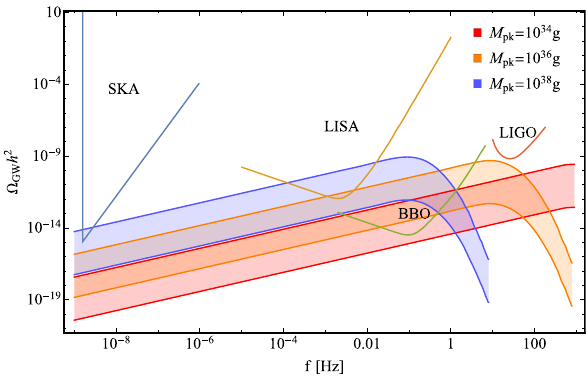
Fig. 6 The GW spectrum of a PBH stellar bubble. We set ˜ f PBH = 1 in the bubble and z = 0 . 01. The mass distribution of PBHs is lognormal with σ = 1 and M pk = 10 34 , 10 36 , 10 38 g for red, orange, and blue shadow regions, respectively. The lower and upper solid curves denote the total PBH mass in a bubble, which are set as 10 45 g and 10 48 g, respectively. Sensitivity curves of SKA [56], LISA [57], BBO [58], and LIGO [59] are plotted